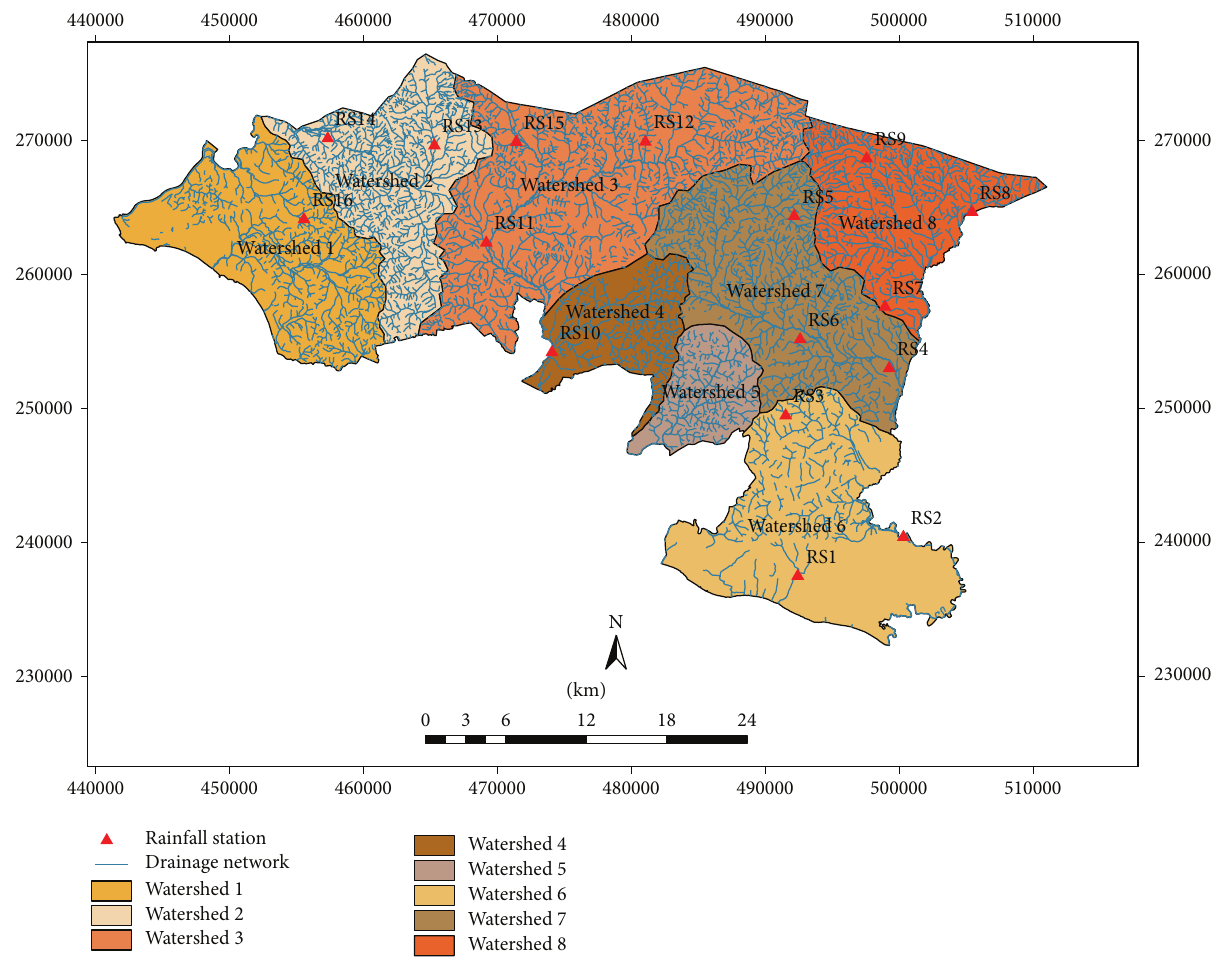
Figure 2: Watersheds and drainage network at Alor Gajah and Jasin.